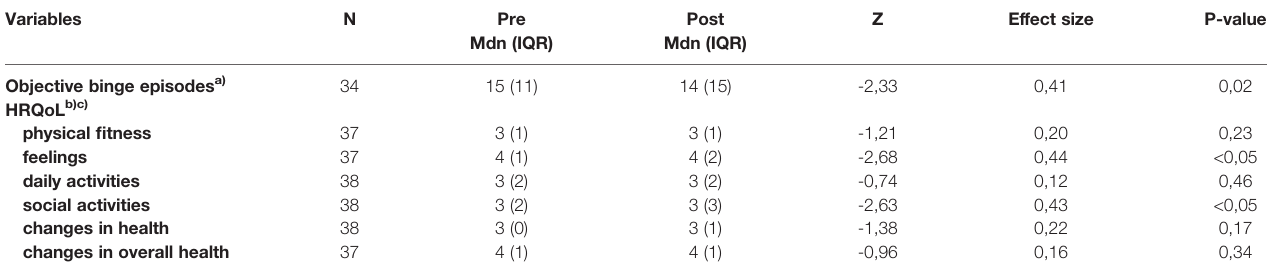
TABLE 3 | Change in binge eating and